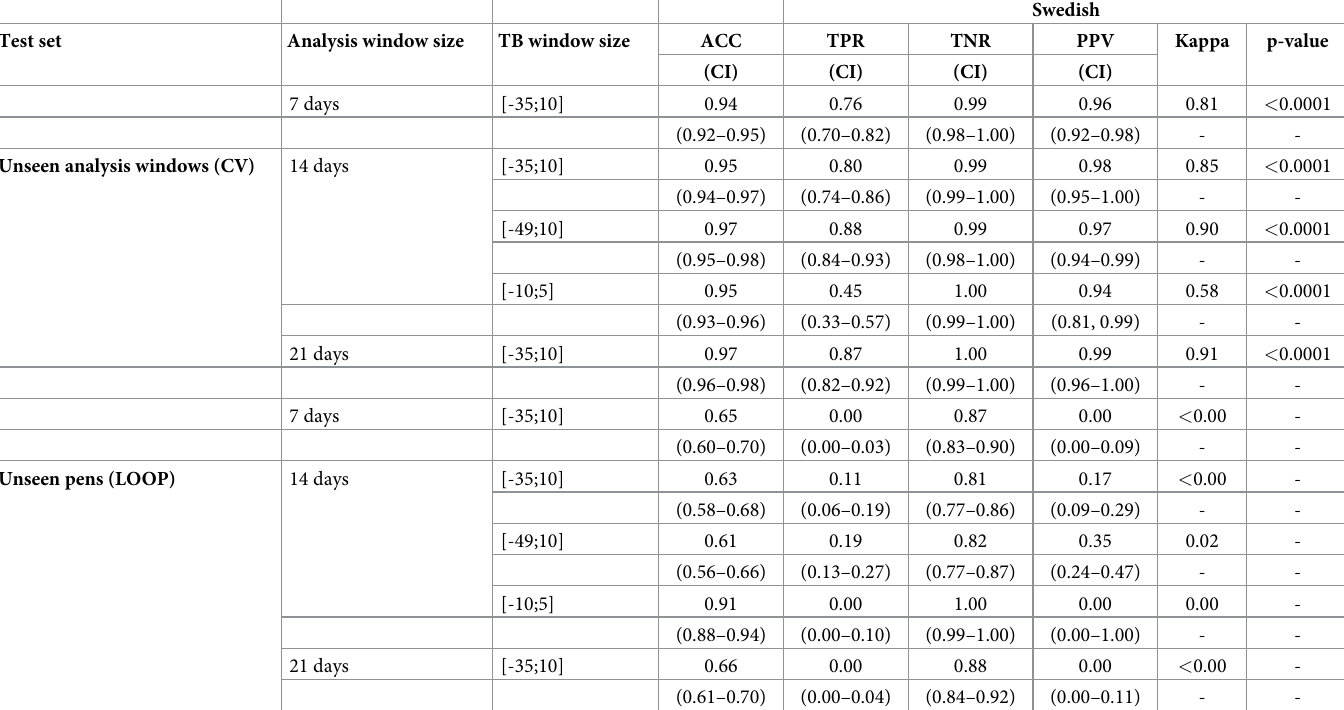
Table 10. Prediction performances of the random forest (rf) model depending on the TB and analysis window size on the Swedish data